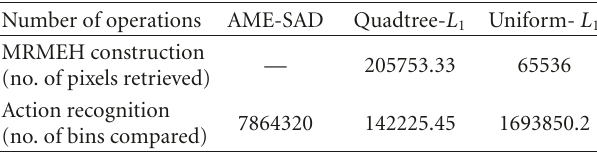
Table 10: Comparisons between AME-SAD and two kinds of partitioning methods in gait classification